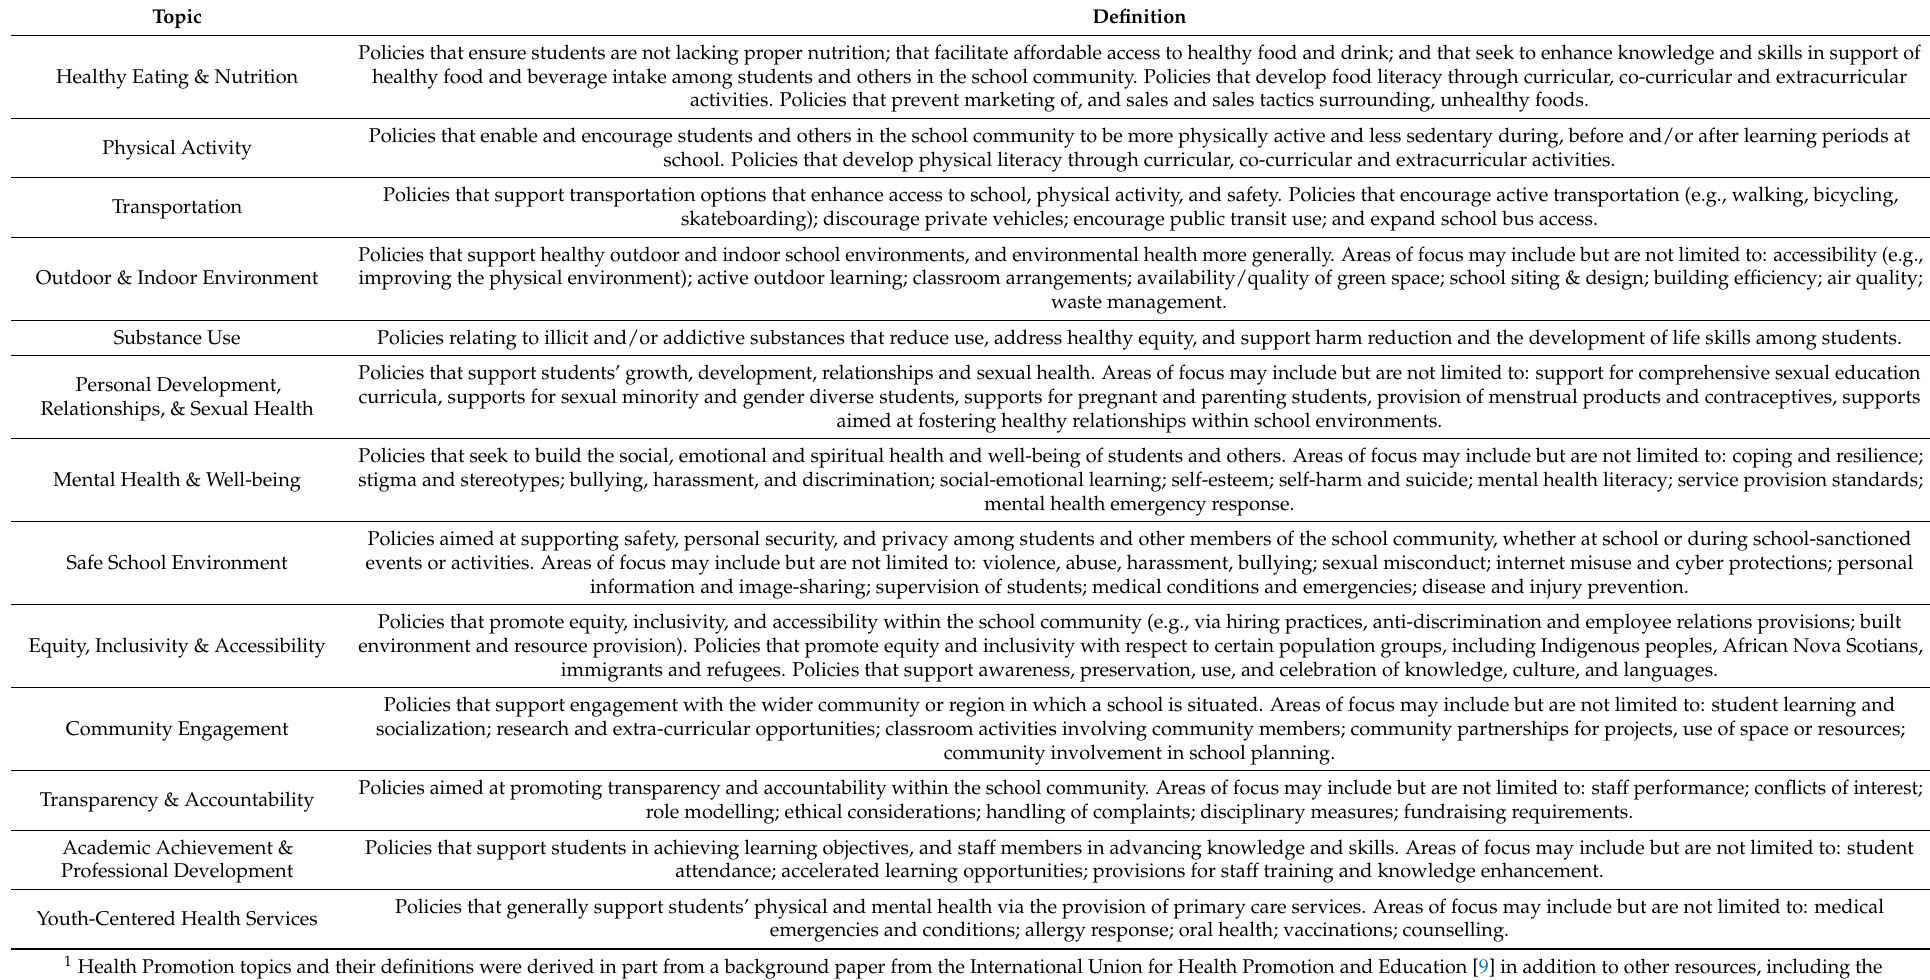
Table 1. Health Promotion topics and corresponding definitions of relevance to the Health-Promoting Schools Framework 1